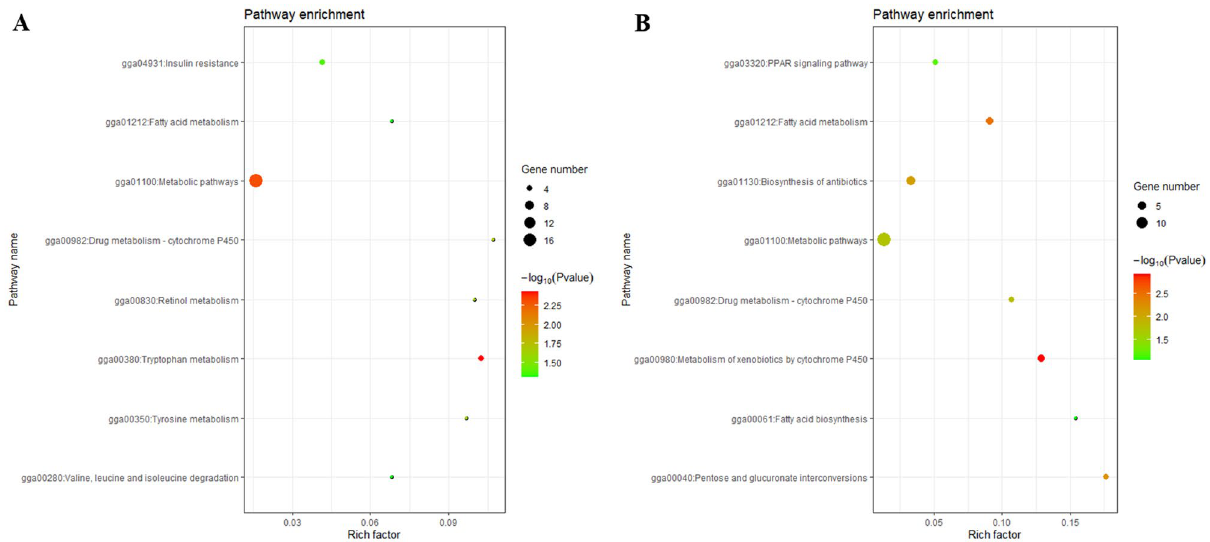
Figure 3. KEGG pathway analysis of the differentially expressed genes ( A ) and proteins ( B ). Fatty acid metabolism and exogenous substance metabolism related pathways can be significantly